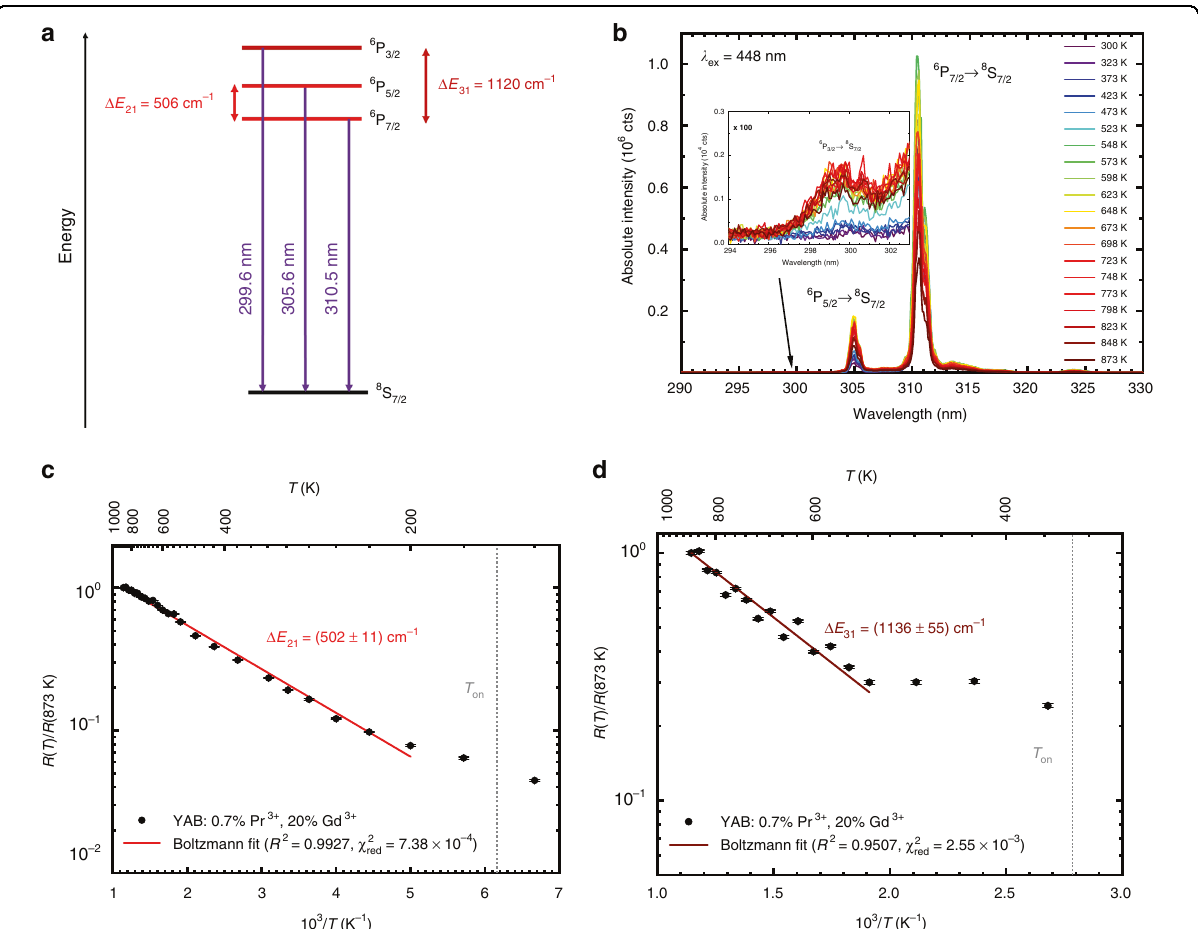
Fig. 3 Boltzmann thermometry was thermodynamically optimized at room temperature and higher temperatures ( T > 500 K) with Gd 3 + in YAB:Pr 3 + , Gd 3 + . a Spin-orbit level scheme and respective radiative transitions depicting the concept for high-precision Boltzmann thermometry with Gd 3 + . b High-resolution upconversion photoluminescence spectra of YAB: 0.7% Pr 3 + , 20% Gd 3 + upon excitation of Pr 3 + at 448 nm showing the radiative transitions from the different 6 P J levels ( J = 7/2, 5/2, and 3/2) of Gd 3 + . The spectra were normalized with respect to the highest intensity peak ( I 10 ~ 10 6 counts) to demonstrate the thermally induced intensity increase of the higher energetic emission peaks. c Boltzmann plot of the temperature-dependent LIR employing the transitions from the 6 P 5/2 and 6 P 7/2 levels, respectively, normalized to its value at 873 K. The fi tted energy gap, statistical fi gures of merit and expected onset temperature for Boltzmann behaviour (Eq. (5)) are indicated. d Boltzmann plot of the temperature- dependent LIR, which employs the transitions from the 6 P 3/2 and 6 P 7/2 levels, normalized to its value at 873 K. The fi tted energy gap, statistical fi gures of merit, and expected onset temperature for Boltzmann behaviour (Eq. (5)) are